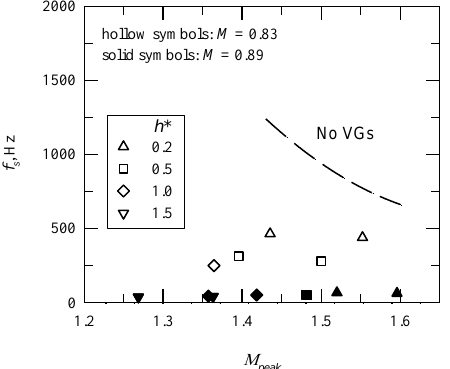
Figure 11. Shock zero-crossing frequency in the presence/absence of VGs.